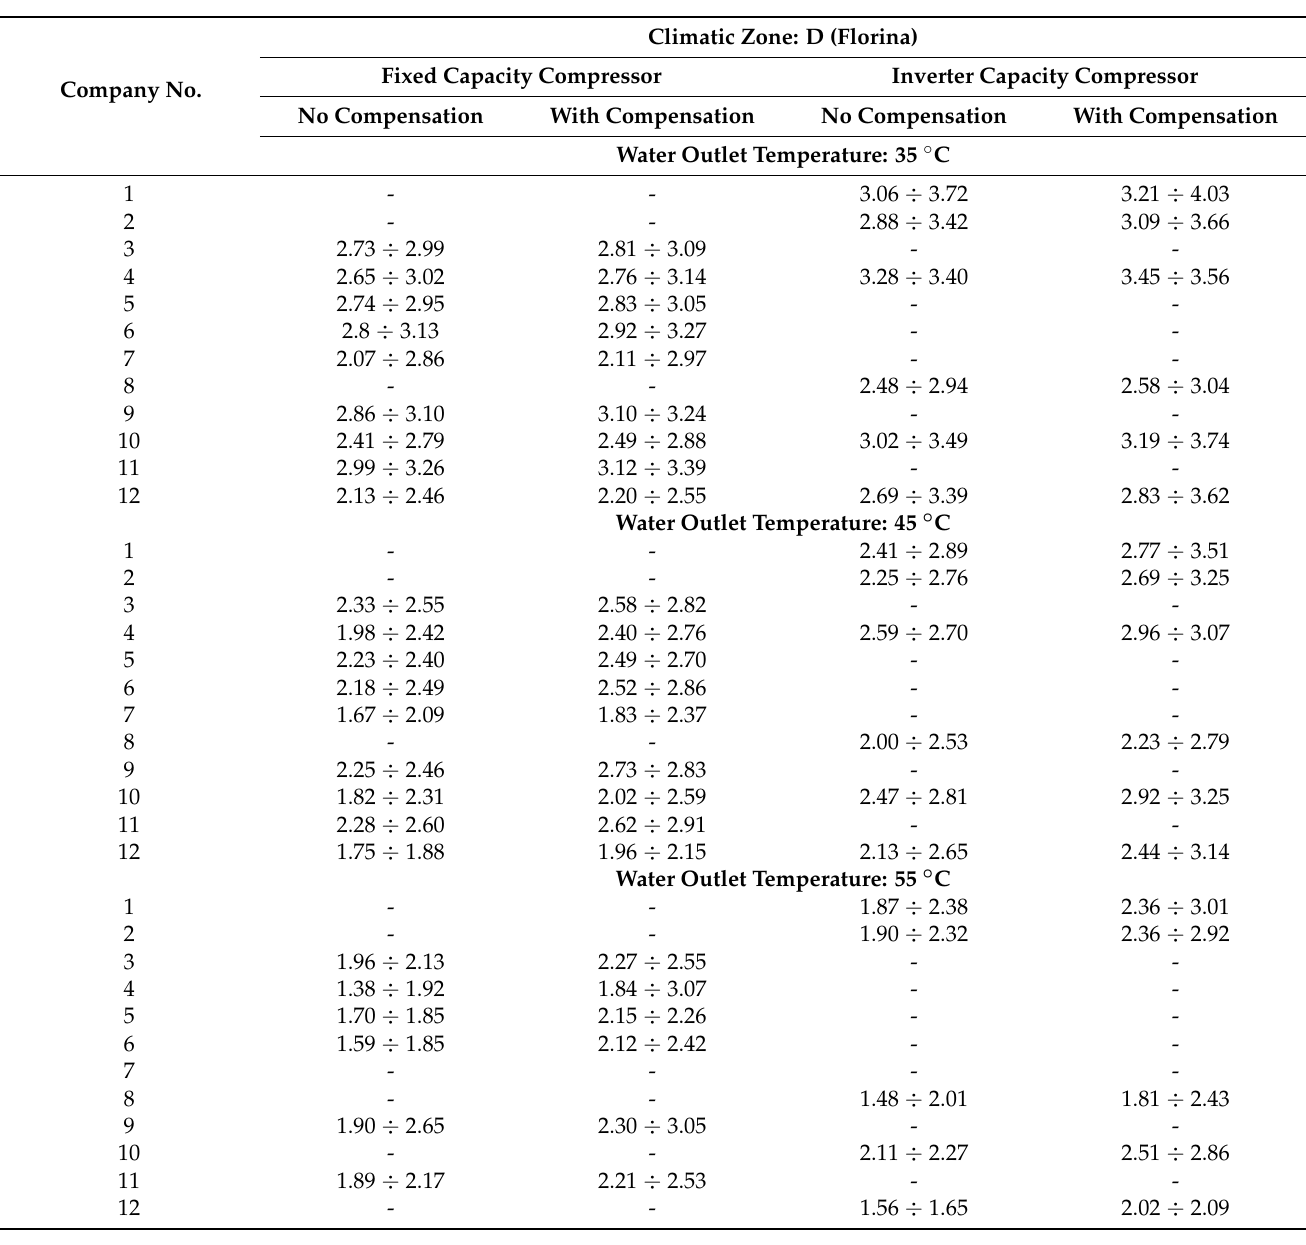
Table 7. AWHPs’ SCOP per company: Florina, water outlet temperature 35, 45, and 55 ◦ C.